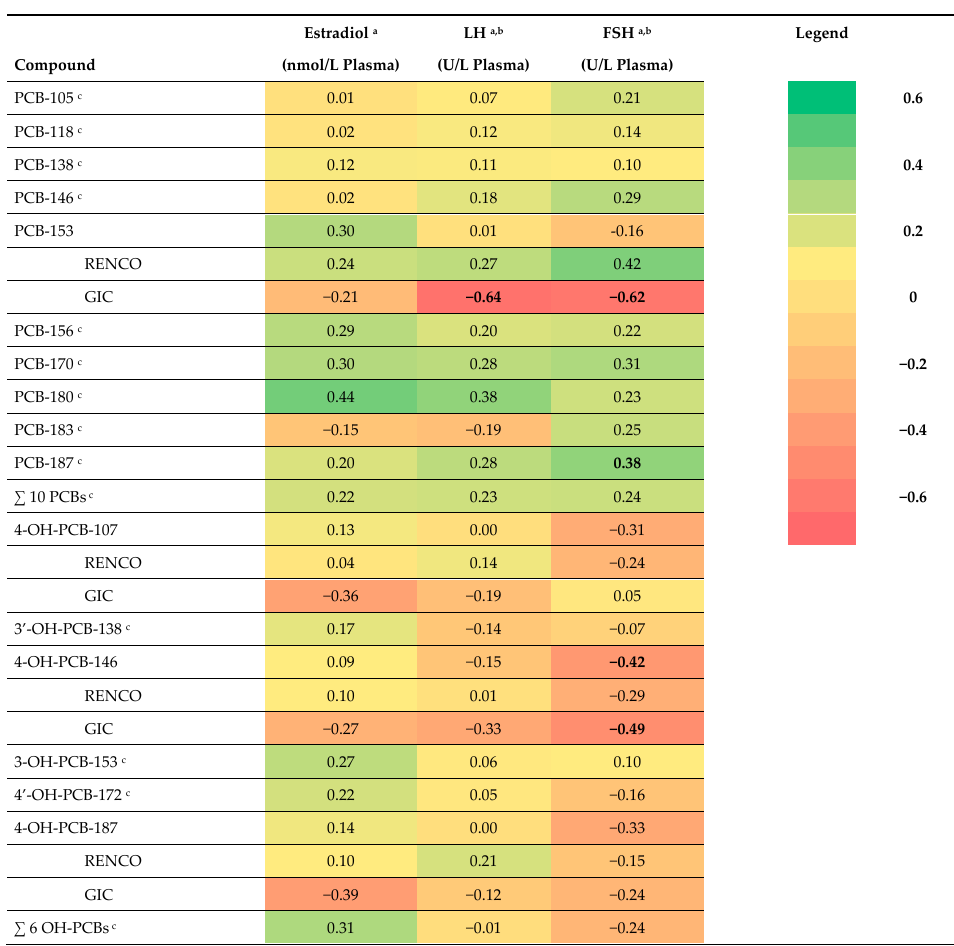
Figure 2. Heat map of adjusted beta coefficients obtained from linear regression analyses performed between log10 transformed prenatal PCB and OH-PCB levels and reproductive hormone levels in girls. LH: luteinizing hormone; FSH: follicle stimulating hormone; associations with a p -value < 0.10 are shown in bold; a adjusted for age at examination in months; b 1 sample < LOD, taken as LOD/2 in analyses; c RENCO cohort.